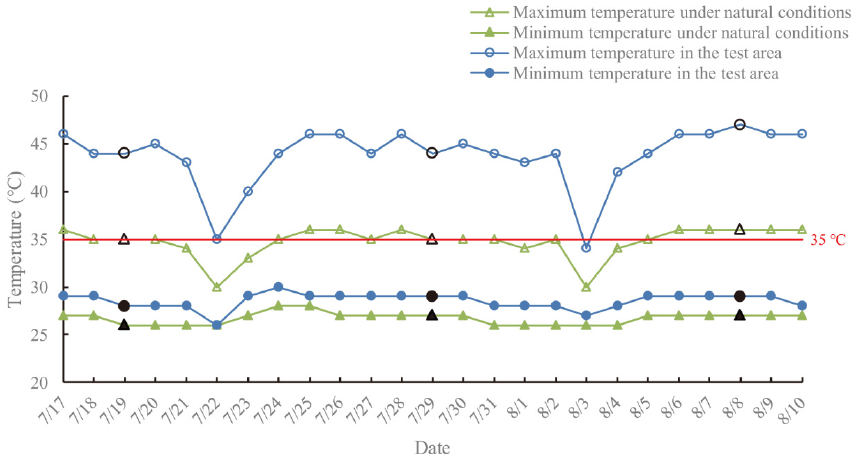
Figure 2. Comparisons between maximum and minimum temperatures in the natural field and test area during the experimental trial. The black marks denote the sampling times. The meteorological data under natural conditions were obtained from the China Meteorological Administration (http://www.cma.gov.cn/ (accessed on 2 October 2021)), and the daily data for the test area were recorded with an agricultural environmental monitor (TNHY-D, TOP Instrument Co. Ltd., Zhejiang, China).